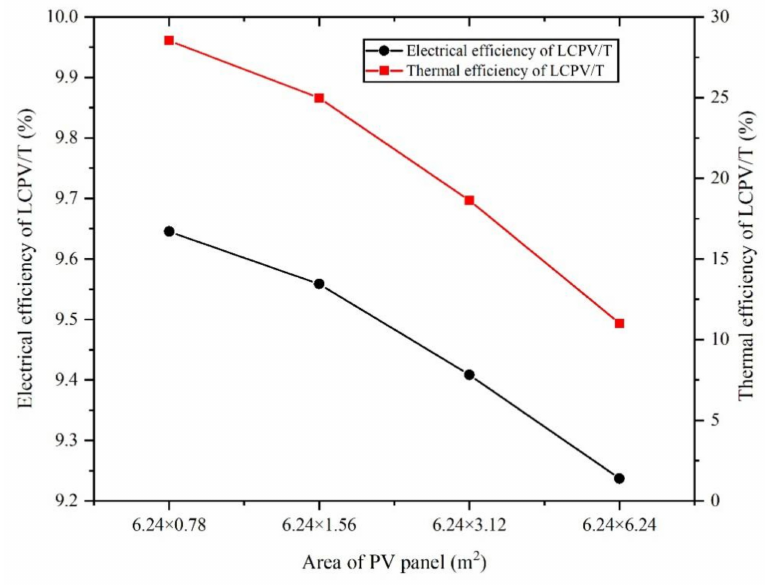
Figure 24. Electrical efficiency and thermal efficiency of the LCPV/T under variable PV cell